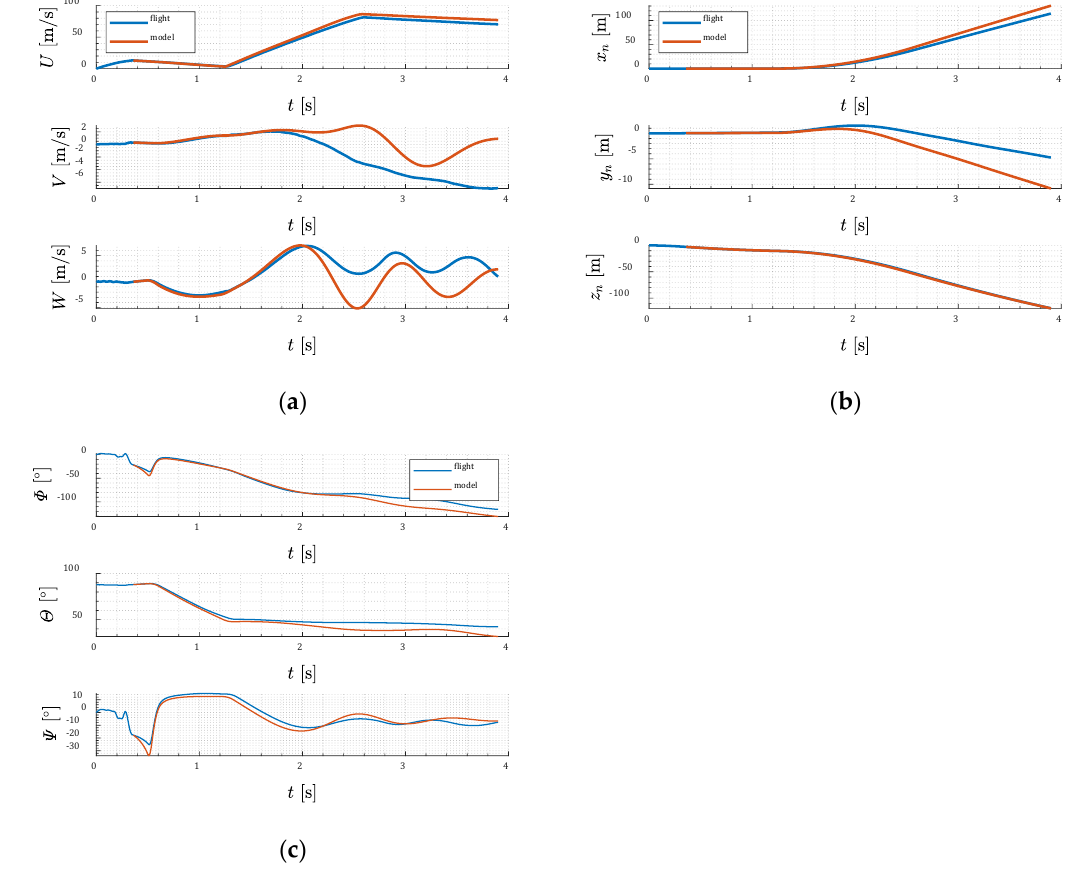
Figure 32. ( a ) Projectile velocity; ( b ) projectile position (test 5, thrusters mounted behind the center of mass); ( c ) Euler angles. Table 6. Mean error and 90th percentile (from launch guide clearance to main motor ignition). Flight